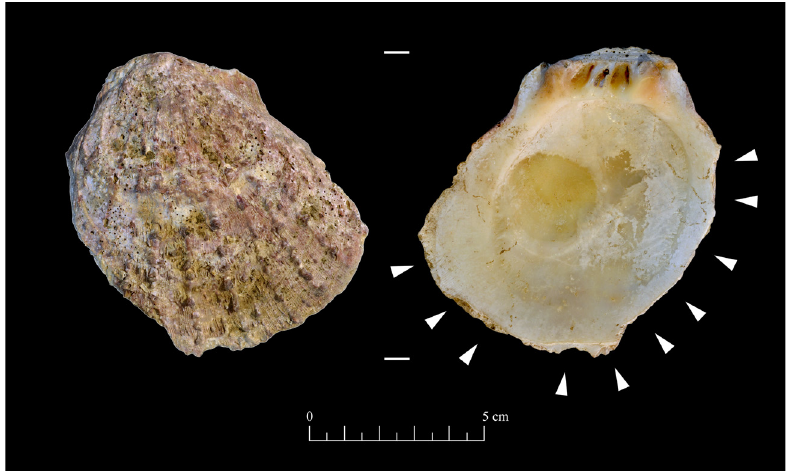
Figure 6: Arene Candide Cave, Cardial Ware horizon: blank obtained from a cut - out Spondylus valve ( after Micheli et al., in press ) .